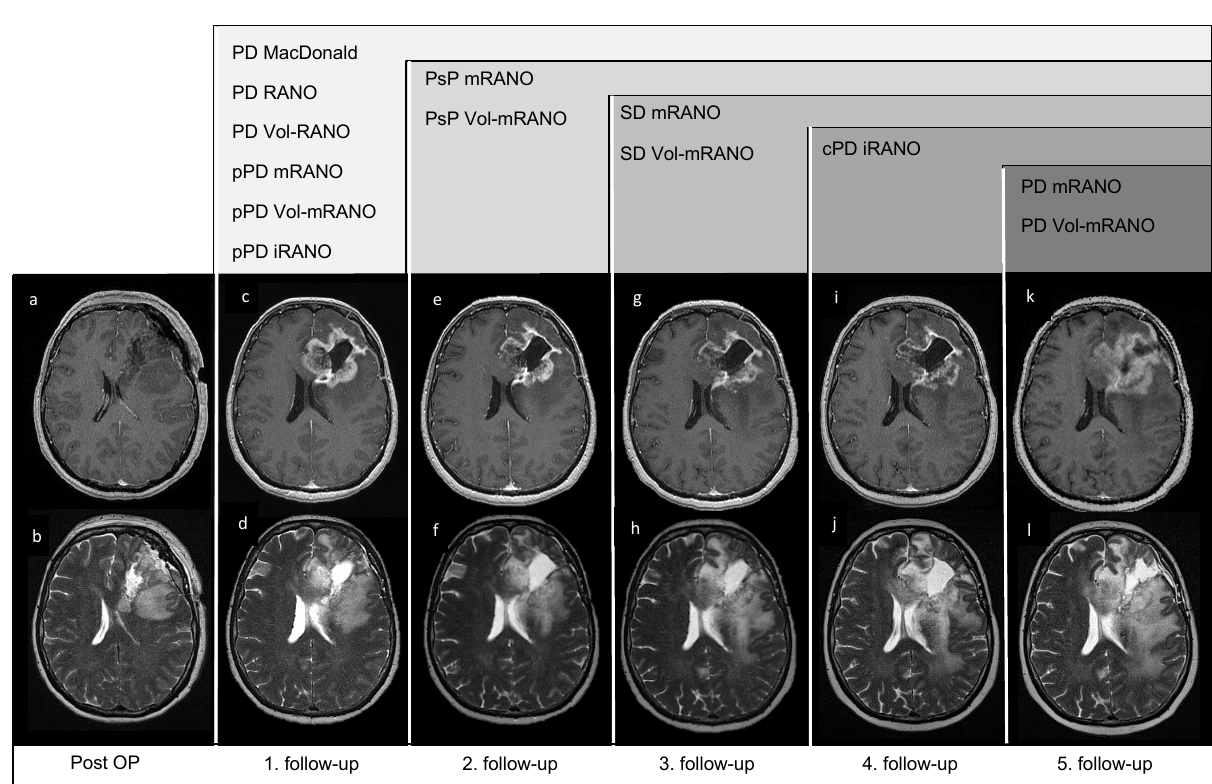
Figure 1. Post-OP and follow-up MRI scans of patient VAX_0083 (Audencel-arm): T2- ( b , d , f , h , j , l ) and postgadolinium T1-weighted MRI sequences ( a , c , e , g , i , k ) are displayed. This figure illustrates the different time points of progression by different response assessments. At the first follow-up scan ( c , d ), a new contrast-enhancing lesion is seen on postgadolinium T1-weighted MRI sequences ( c ) and a significant increase or ≥ 100% increase in volume of non-enhancing abnormalities ( d ) compared to the post-OP scan (baseline, ( b )) is seen. Progressive disease (PD) by MacDonald, RANO, Vol-RANO, while preliminary progressive disease (pPD) by mRANO, Vol-mRANO is diagnosed. Because the first follow-up MRI ( c , d ) is within the first six weeks of immunotherapy-treatment start, pPD by iRANO is defined. In the second follow-up MRI ( e , f ) this patient is diagnosed with pseudoprogression (PsP) because no further ≥ 25% increase in the cross-section area or ≥ 40% increase in total volume of the contrast-enhancing tumor mass is seen ( e ) compared to the first follow-up MRI ( c ). In the third follow-up MRI ( g , h ) the contrast-enhancing tumor mass does not increase in size ( g ) compared to